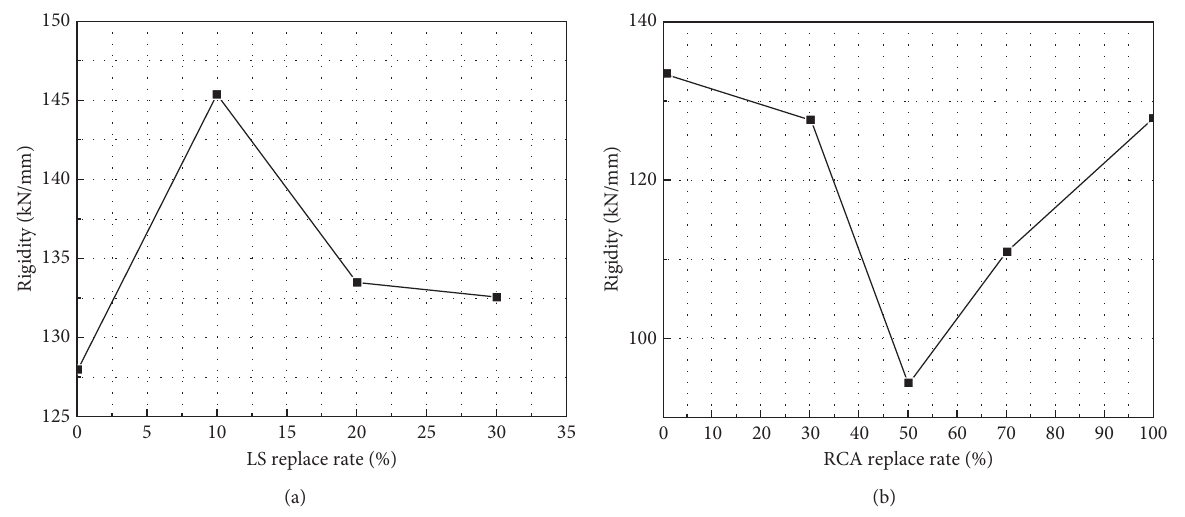
Figure 6: Effect of different parameters on the stiffness of